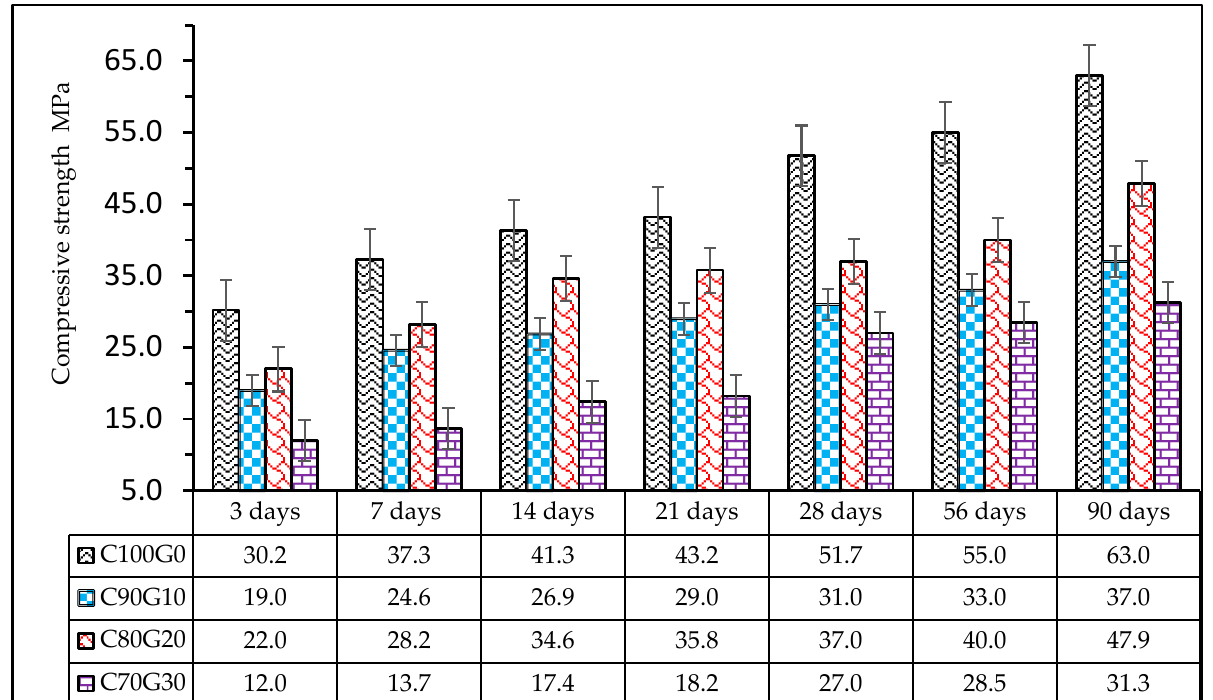
Figure 9. Experimental and predicted value of glass blended cement mortar . From Figure 10, the compressive strength of concrete increases with days of maturity. The rate of strength development in C 70 G 30 is higher (48.3 wt.%) between 21–28 days Concrete sample C 80 G 20 has the best strength characteristics, and its maximum 3-day in comparison with 56–90 days, where 9.2% only was achieved. Similarly, C 80 G 20 devel- early strength was 22 MPa, which was 27.2% of the achievable strength in C 100 G 0 (glass- oped 3.35% between 21–28 days, whereas the development was 19.75% between 56–90 free). This decreased to 37.2% and 60.3% in C 90 G 10 and C 70 G 30 , respectively. The strength days. This implies that there were significant pozzolanic reactions in glass blended con- development increased linearly with a 90-day strength of 63 MPa in C 100 G 0 and 47 MPa crete at a later time beyond 56 days. Therefore, we can conclude that glass present in OPC in C 80 G 20 (20% glass). The strength achieved in this sample could be regarded as high- concrete underwent a delayed pozzolanic reaction, thereby corroborating the hydration strength concrete. As the glass contents of 10 wt.% (C 90 G 10 ) and 30 wt.% (C 70 G 30 ) were of belite (C 2 S). added, the strength reduced by 22.8% and 34.7%, respectively.